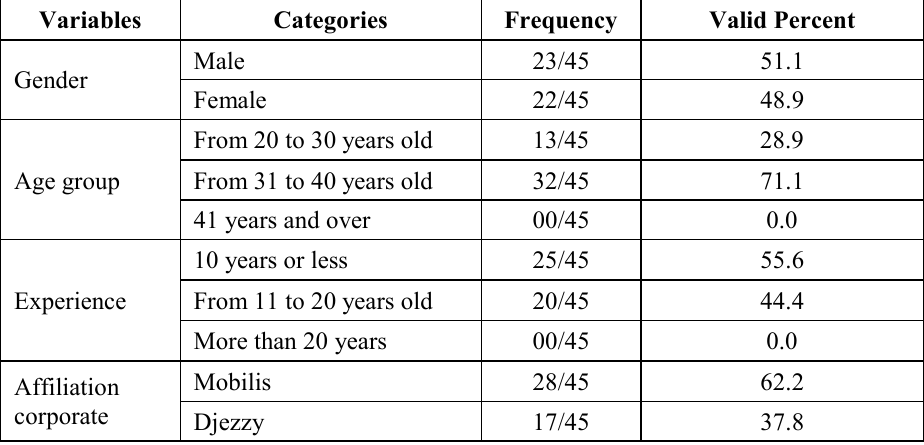
Table 3. Distribution of the Sample According to its